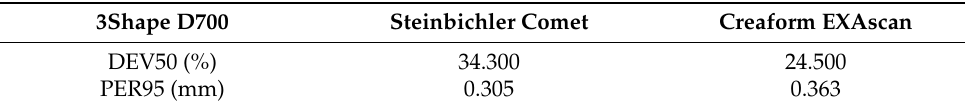
Figure 10. Histogram of the distribution of deviations. Table 3. Comparison with the reference scan of the